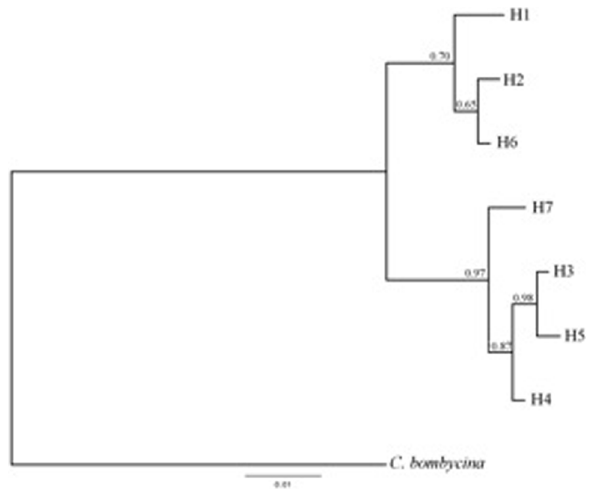
Figure 4. A Bayesian Inference phylogram of all seven C. emmae’s haplotypes obtained from MtDNA COI (622 bp) data. Values by nodes indicate Bayesian Inference posterior probabilities